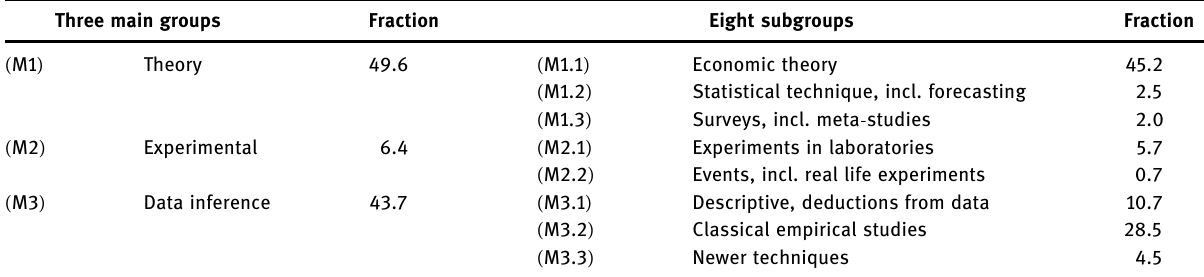
Table 2: The 3,415 papers – fractions in percent Three main